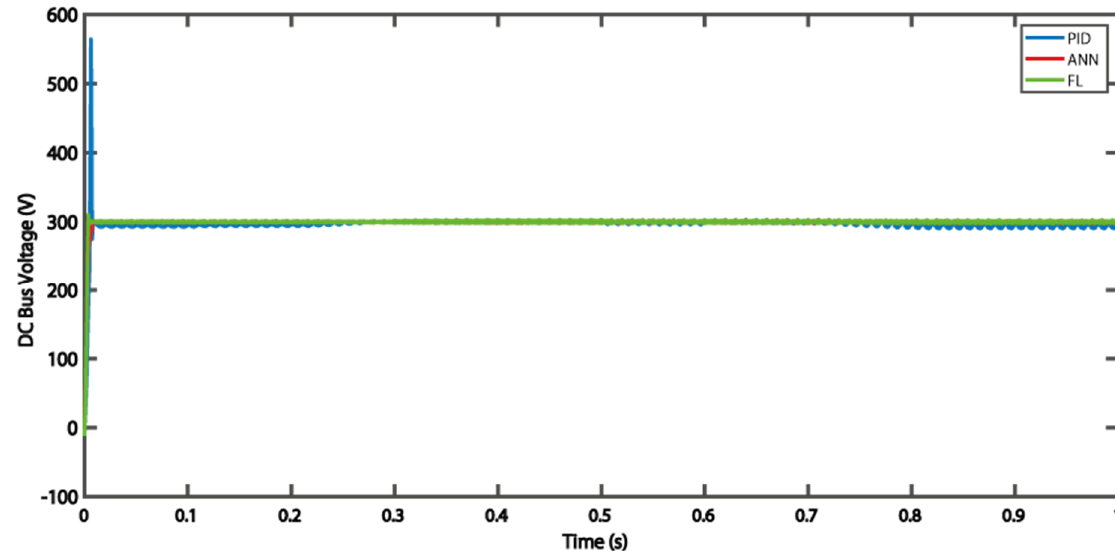
Figure 20. Measured voltage at the DC bus (V).